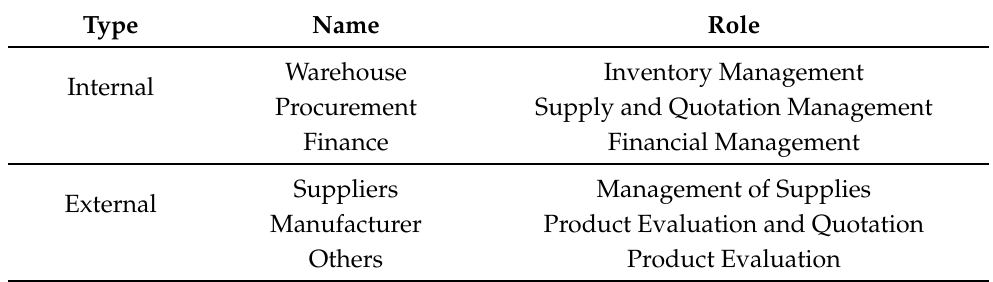
Table 1. Types of supply chain process